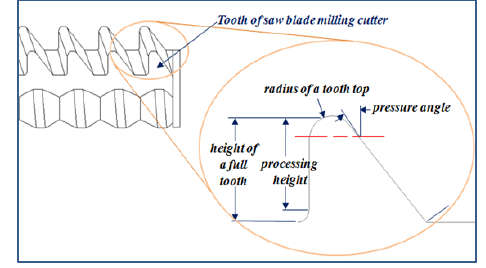
Figure 5. “Saw blade milling cutter”. Figure 6. “The measurement parameters of a saw blade milling